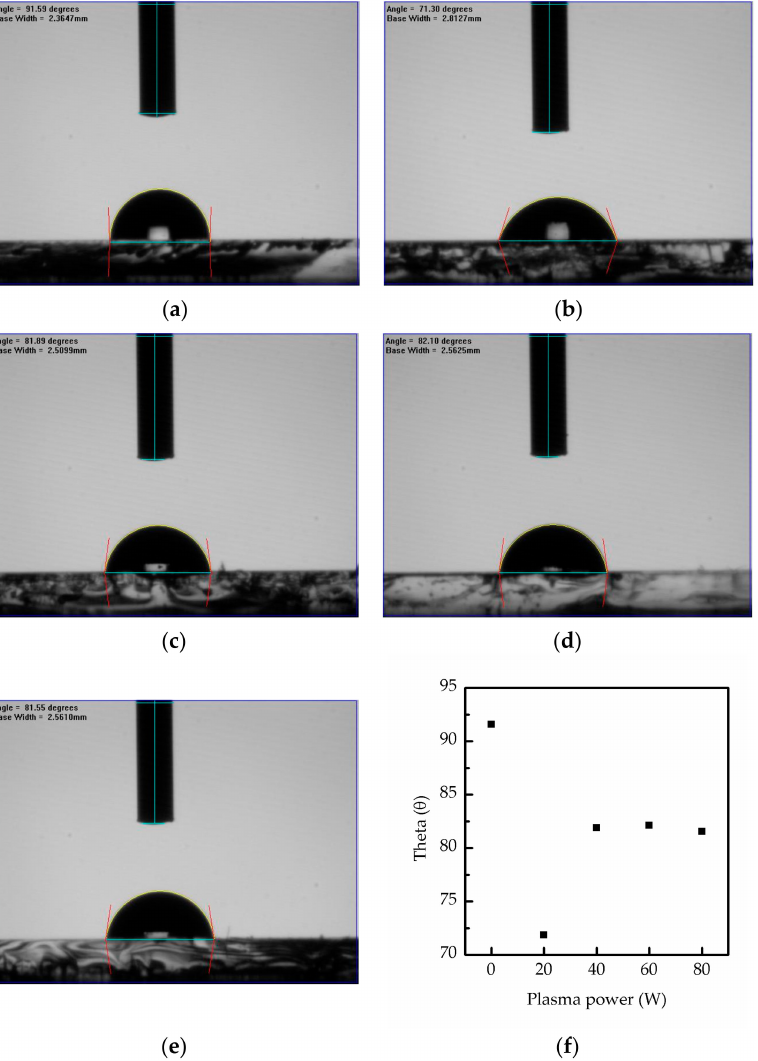
Figure 5. Contact angles of perovskite films composed of MAPbI 3 and CsPbI 3 QDs after surface treatment at various oxygen plasma powers from 0 to 80 W, ( a ) 0 W, ( b ) 20 W, ( c ) 40 W, ( d ) 60 W and ( e ) 80 W. And ( f ) the contact angles is consolidated in